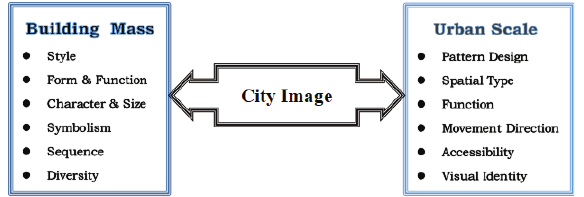
Figure 10. Factors infl uencing the assessment of a city’s